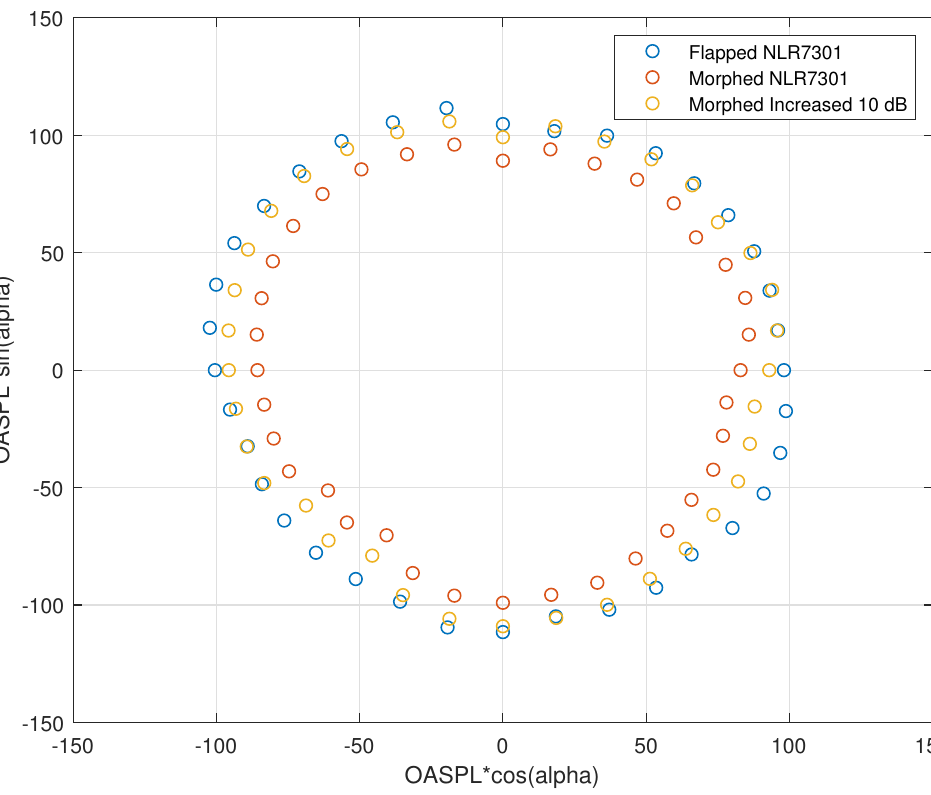
Figure 21. OASPL comparison for the NLR7301 plus trailing-edge flap and morphed airfoil.